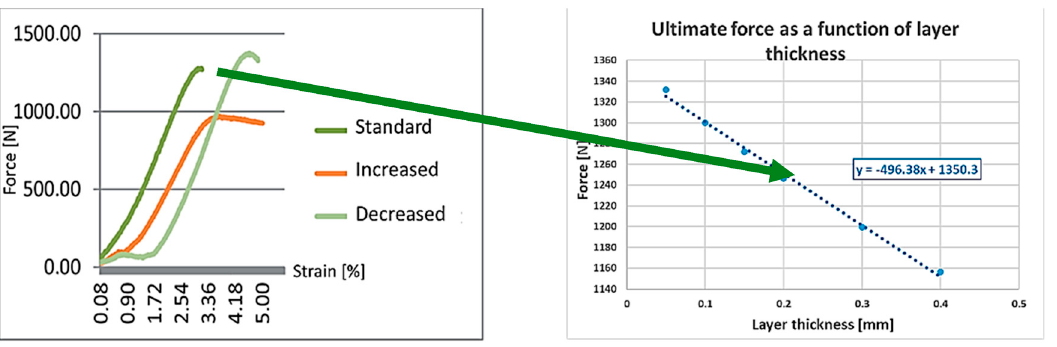
Figure 10. The calculated tensile strength as a function of layer thickness. Layer thickness had the most significant effect on the failures. The layer thickness range was between 0.05 and 0.4 mm. The extreme values are not in the practically used range, although the instrument is able to produce them. The 0.1 mm thickness is not visible and, in the case of 0.4 mm, the porosity is unacceptable. Figure 11 shows a SEM picture, where the layer thickness is 0.3 mm; it seems to be the highest thickness from practical point of view